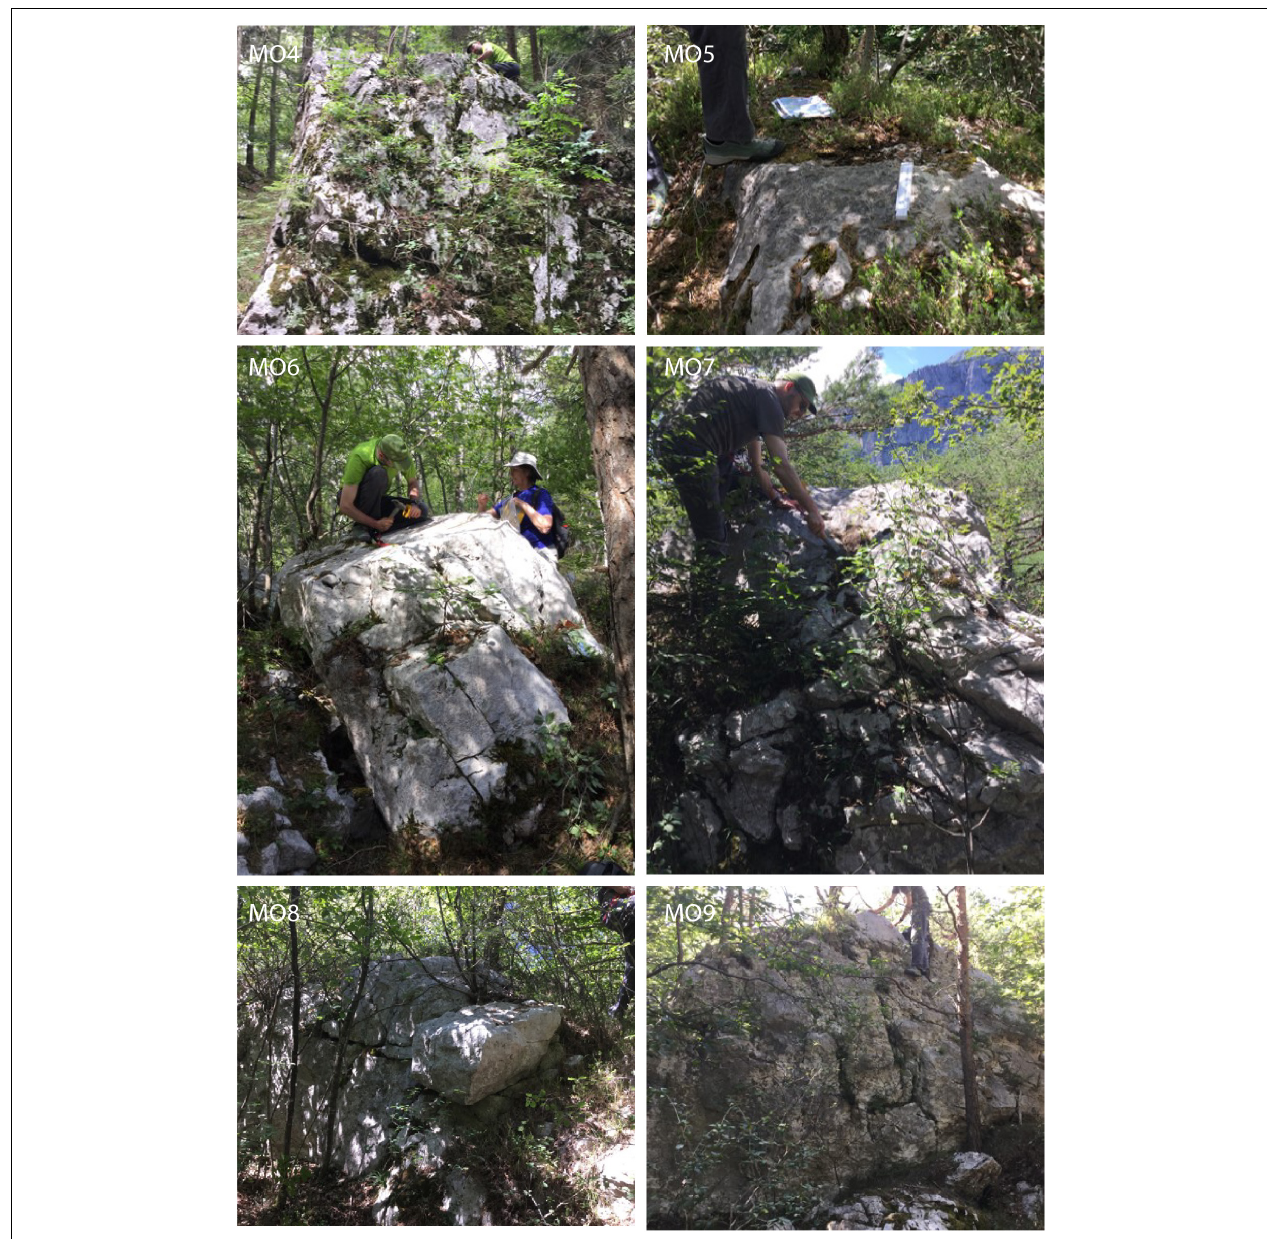
FIGURE 4 | Examples of boulders used for surface exposure dating ( Table 1 ). Written informed consent was obtained from the individuals for the publication of any potentially identifiable images or data included in this